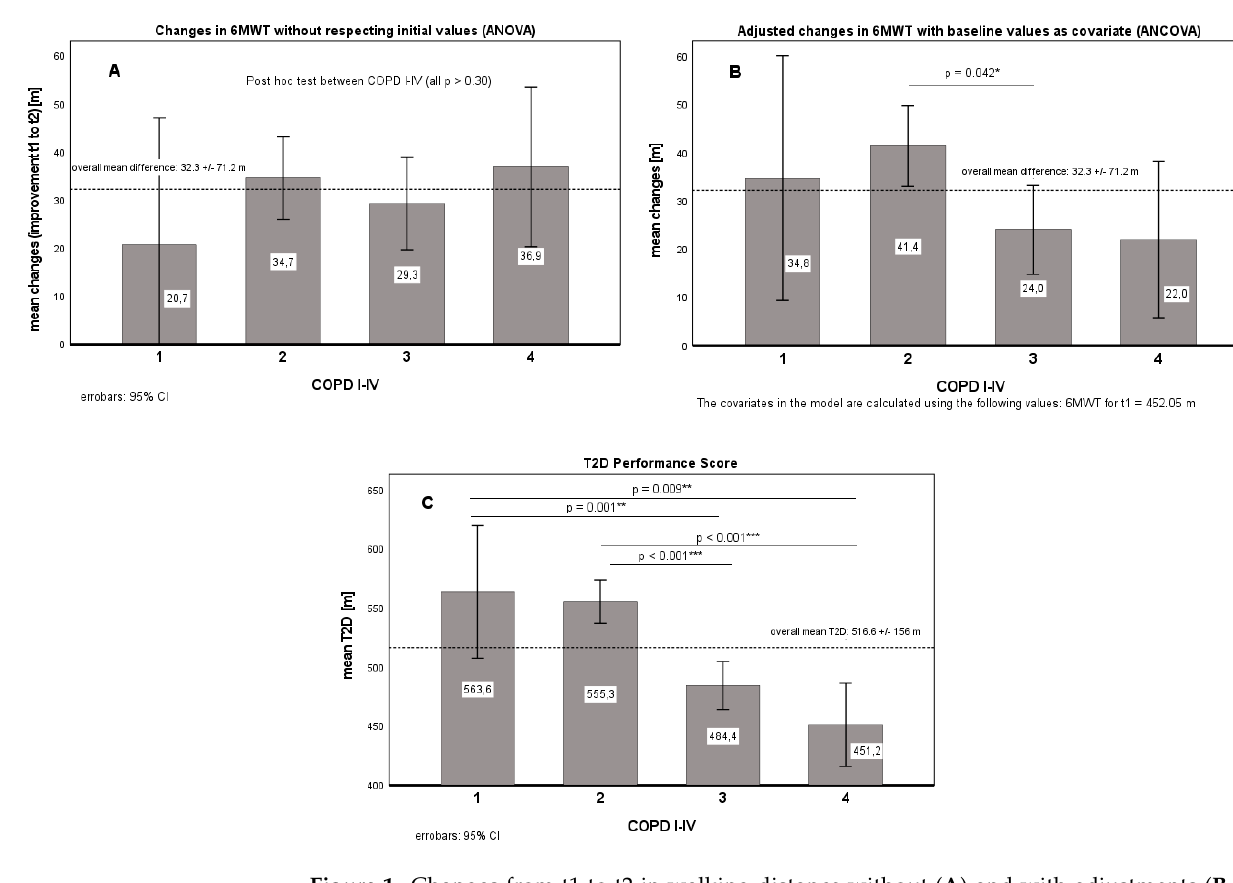
Figure 1. Changes from t1 to t2 in walking distance without ( A ) and with adjustments ( B , C ) for baseline values. Figure 1A: no adjustments, COPD group: p = 0.636 (part. Eta 2 = 0.003); Figure 1B: with covariate (6MWT t1 ); covariate: p = 0.000 *** (part. Eta 2 = 0.098), COPD group: p = 0.035 * (part. Eta 2 = 0.015); Figure 1C: T2D, COPD group: p = 0.000 *** (part. Eta 2 = 0.081); Significance level: * p < 0.05, ** p < 0.01, *** p <